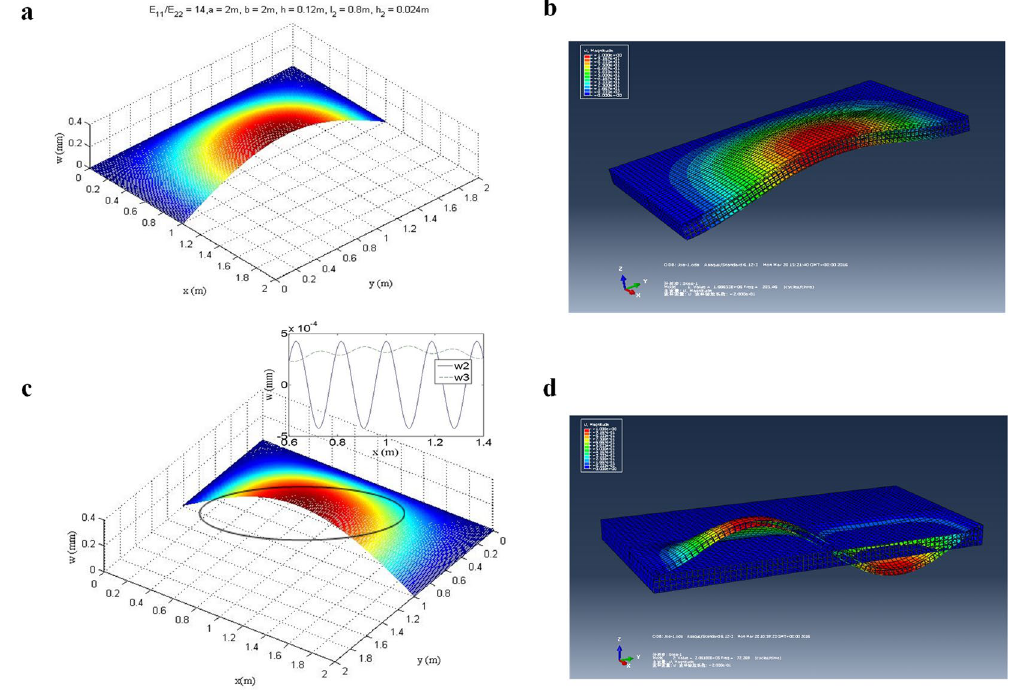
Figure 3. Free vibration modes for η = 0.5 and τ = 0.3. ( a ) Profile of analytical vibration mode at cross-section x = a /2. ( b ) Profile of vibration mode at cross-section x = a /2 from ABAQUS with interaction penalty. ( c ) Profile of vibration mode with local buckling superposed. ( d ) Vibration mode from ABAQUS without interaction penalty.